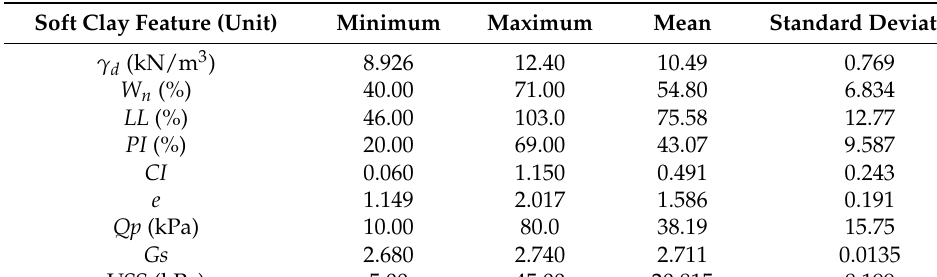
Figure 1. Plot of ( a ) PL, ( b ) W n , and ( c ) LL versus depth. Table 1. Statistical analysis of the dataset of soft clay features.